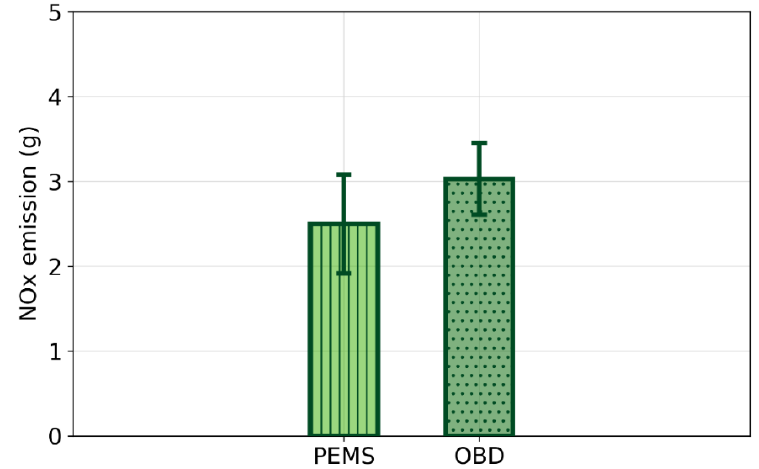
Figure 6. Vehicle 2 average of the cumulative NOx emissions measured at tailpipe with a portable emission measurement system (PEMS) and with the on-board NOx sensor (OBD) in 2 RDE-compliant tests.